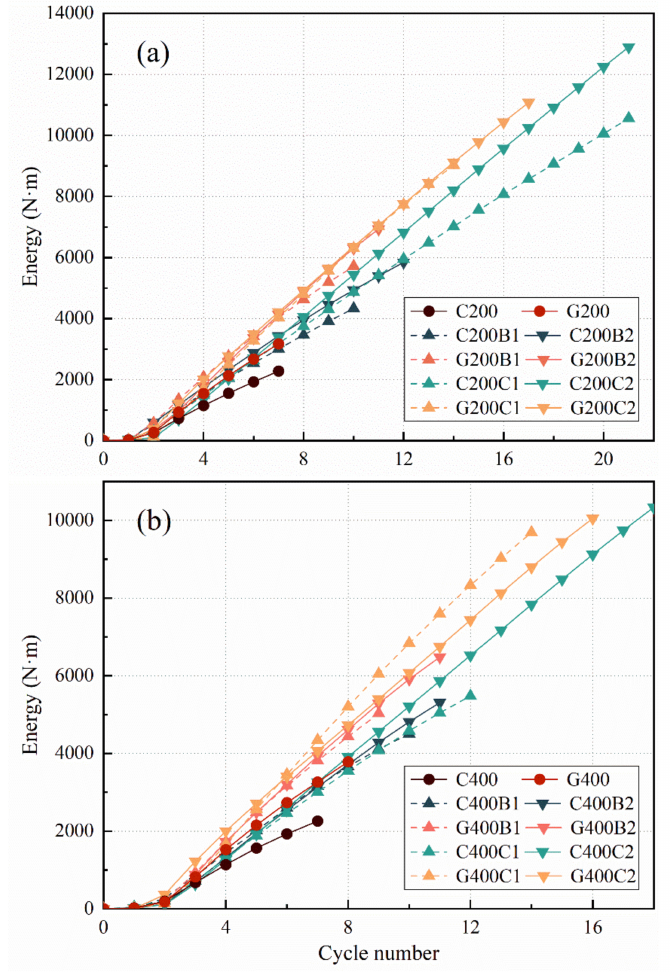
Figure 11. Cumulation of hysteresis energy dissipation: ( a ) Specimens 200 mm high; ( b ) Specimens 400 mm